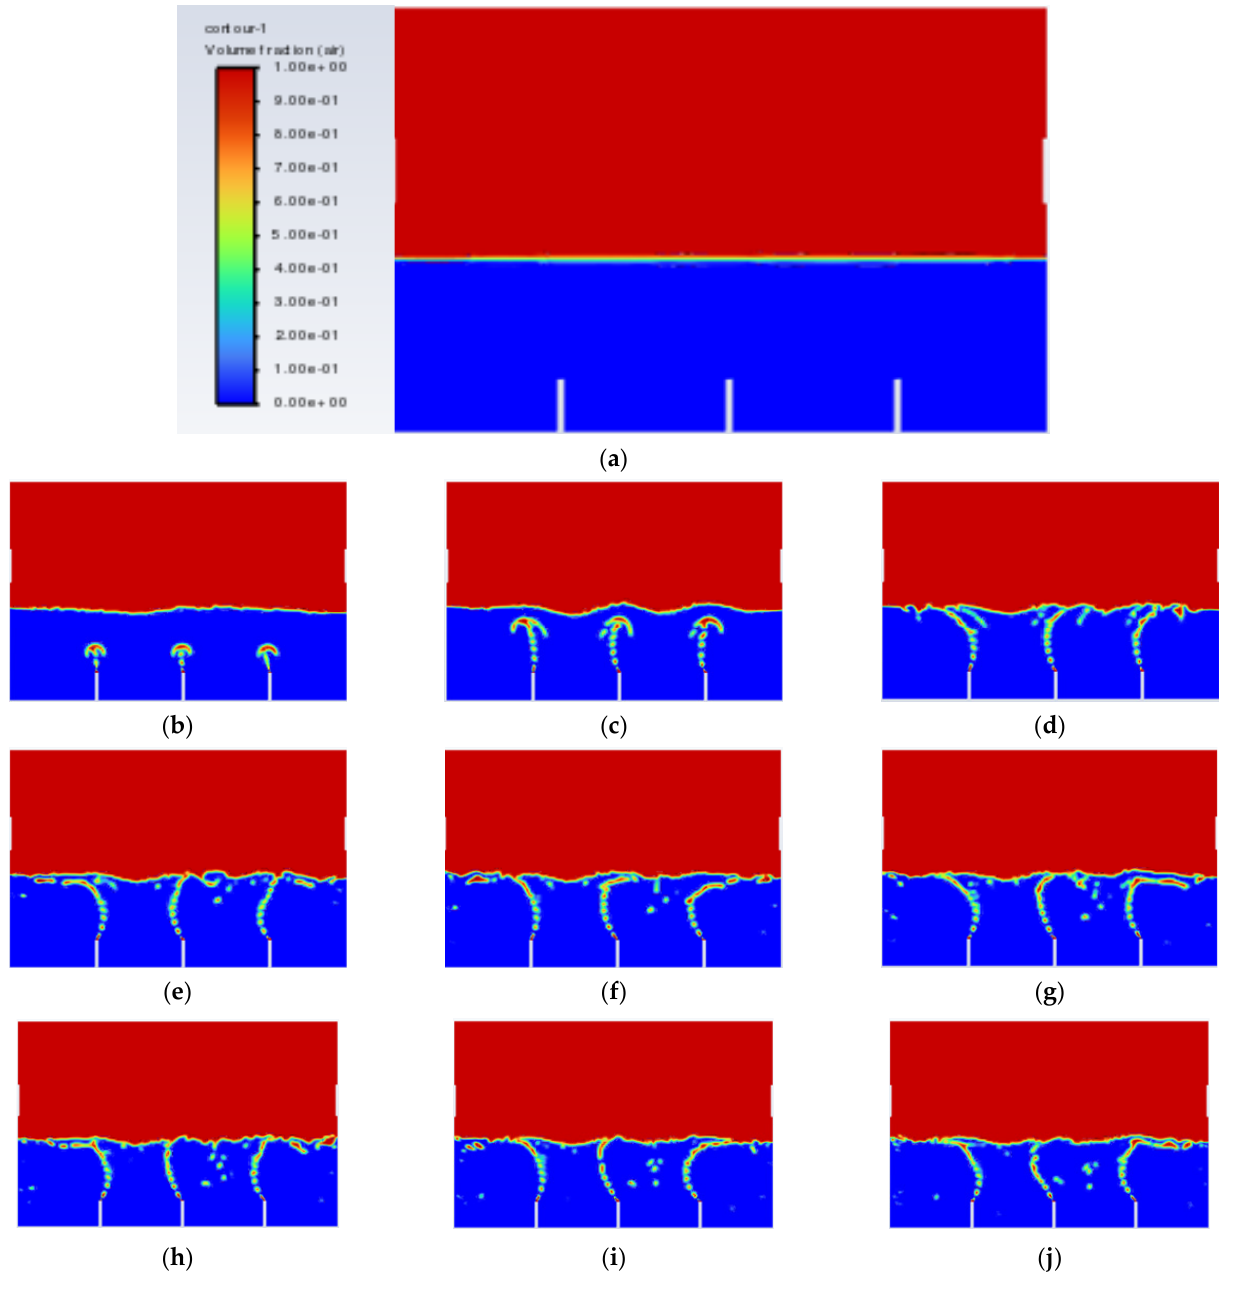
Figure 14. Air-phase contour of Simulation 5: ( a ) 0.00 s; ( b ) 0.25 s; ( c ) 0.50; ( d ) 0.75 s; ( e ) 1.00 s; ( f ) 1.25 s; ( g ) 1.50 s; ( h ) 1.75 s; ( i ) 2.00 s; ( j ) 2.25 s.